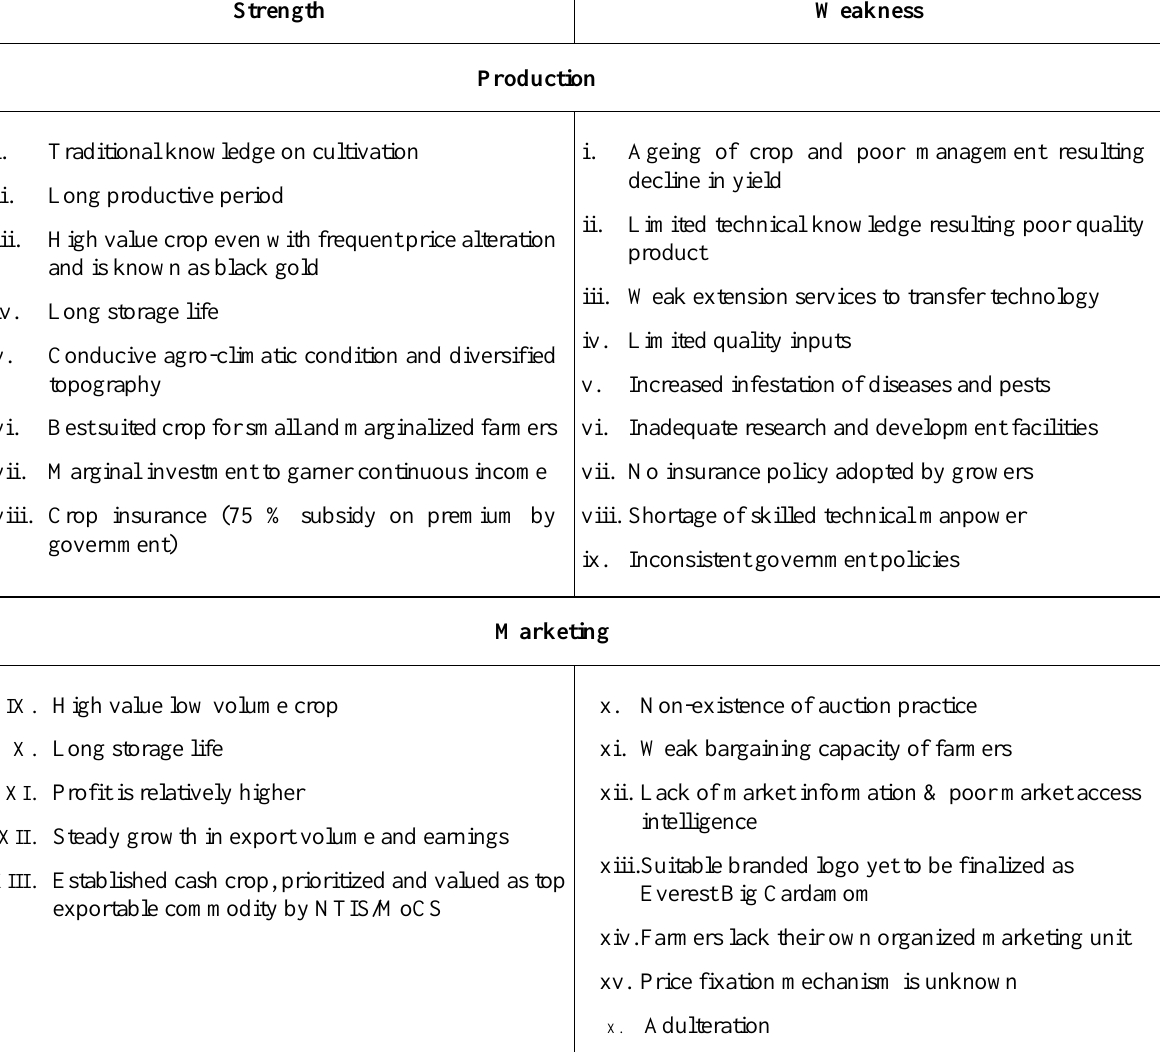
Table 15. Strength, weakness, opportunities and threats of large cardamom production and